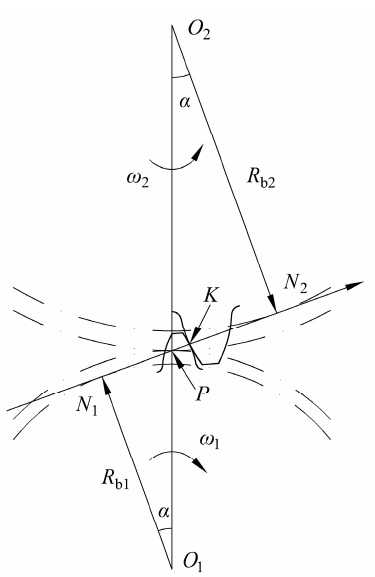
Figure 1. Gear meshing